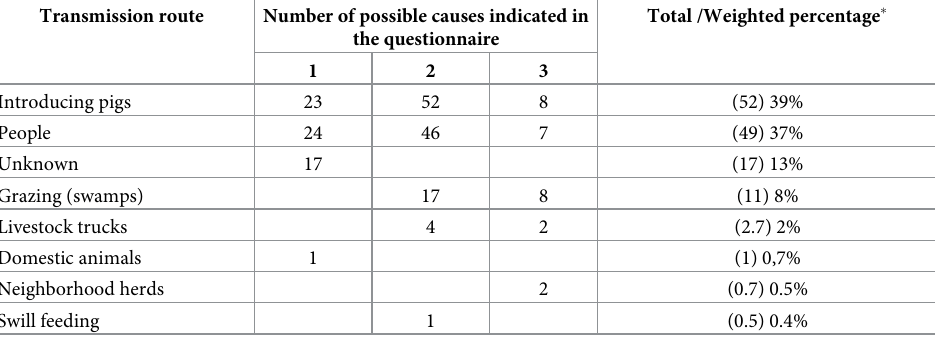
Table 3. Possible causes of the introduction of the CSFV into the epidemiological units according to question- naires and records.